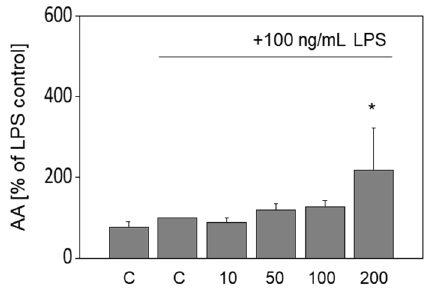
Figure 5. Effects of oleic acid (OA) on the release of arachidonic acid (AA). The release of AA in LPS-stimulated RAW264.7 macrophages is increased by incubation with OA. Cells were pre-incubated with serum-free medium, and the concentrations of OA as indicated for 4 h followed by a co-incubation of OA with 100 ng/mL LPS for an additional 20 h. Untreated control samples (C) were cultured with serum-free medium for 4 h plus another 20 h; values of positive controls (LPS) were defined as 100%. Data are shown as mean levels ± standard deviation of three independent biological replicates. Significant differences compared to the LPS control (* p < 0.05) were obtained by ordinary one-way ANOVA test.